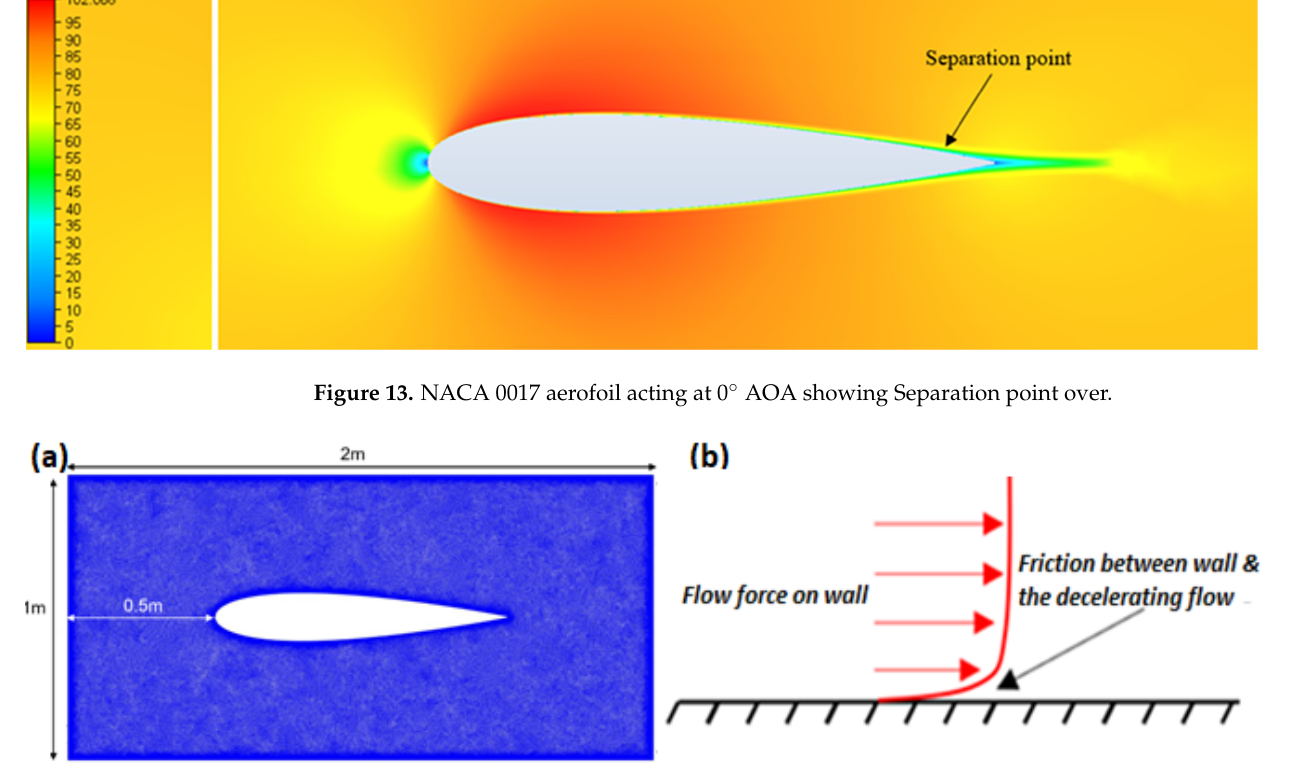
Figure 14. Creation of the ( a ) boundary domain mesh and ( b ) boundary layer showing friction re- gion.